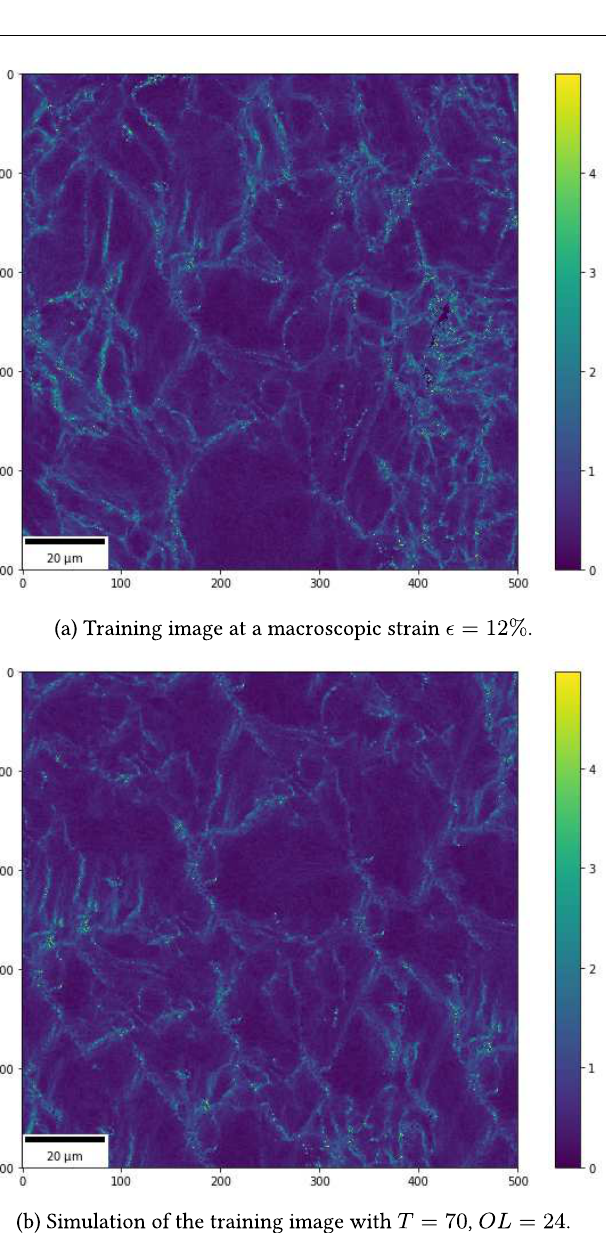
Fig. 7. High quality simulation example – EMD = 0 . 087